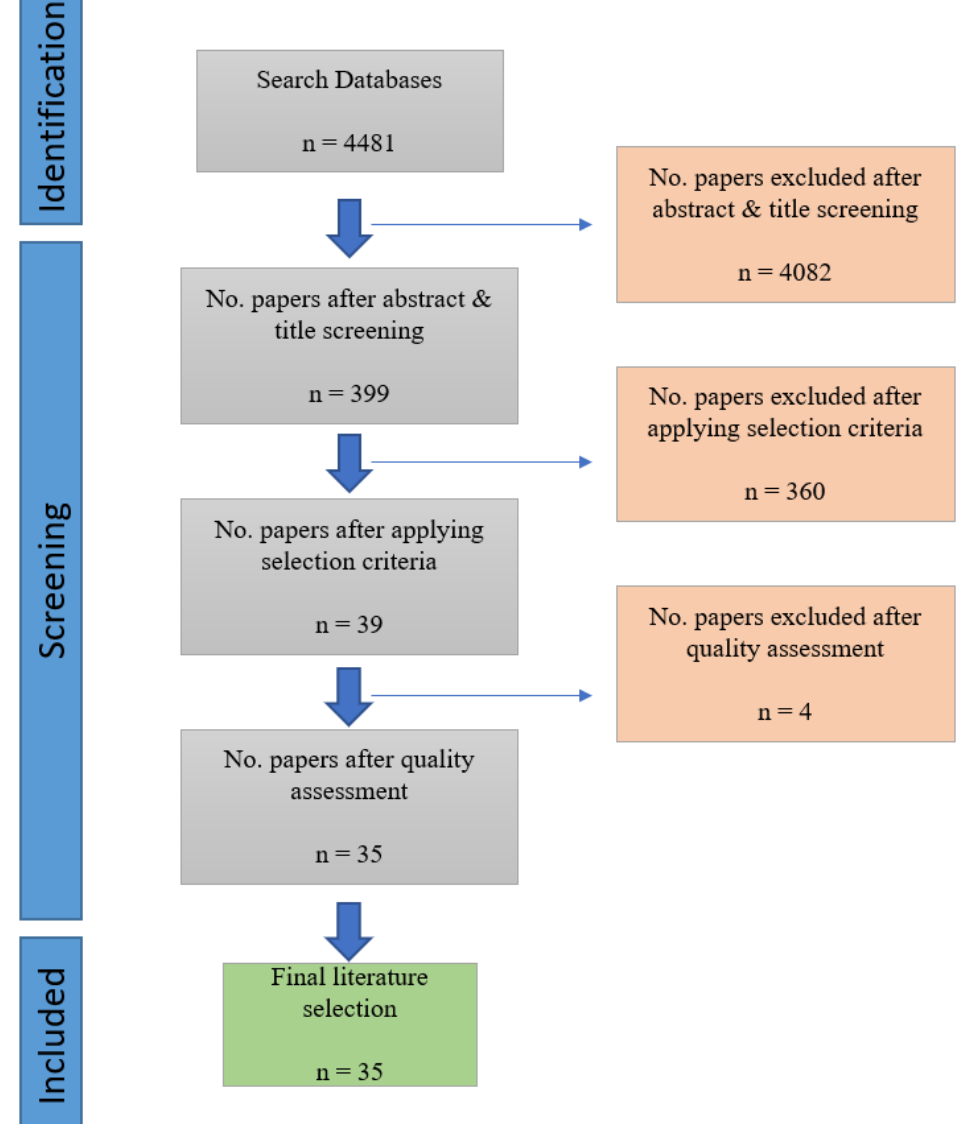
Figure 1. Flowchart search